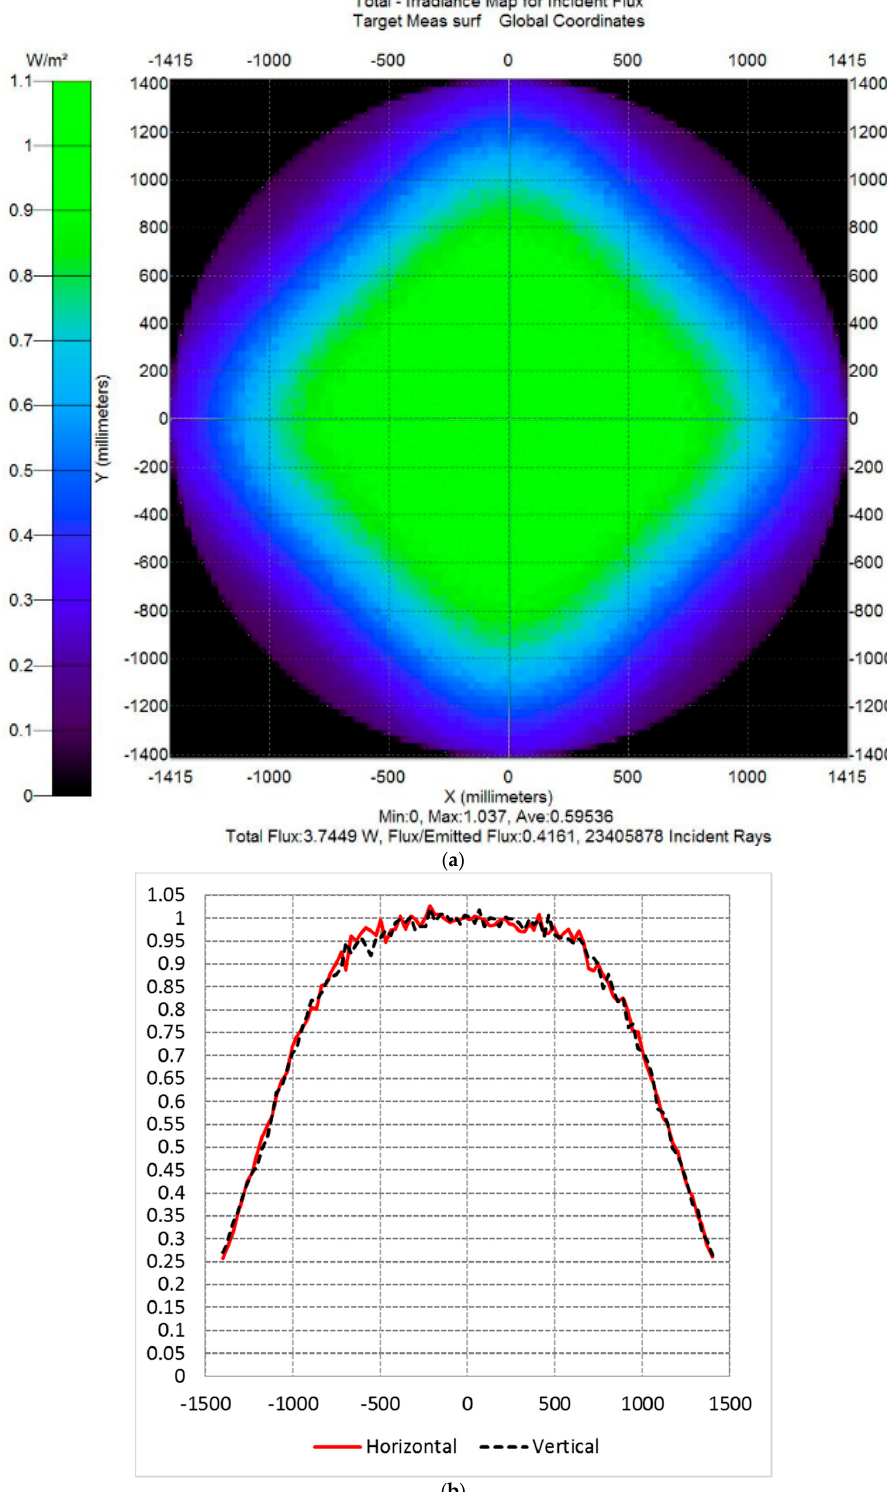
Figure 4. Target irradiance map ( a ) and corresponding central profiles ( b ) with mirror side L F = 2 m.